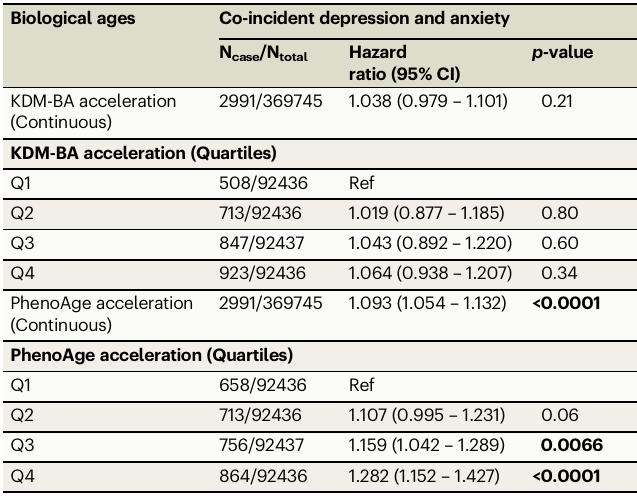
Table 4 | Associations of biological ages at baseline with co- incident depression and anxiety at follow-up a Biological